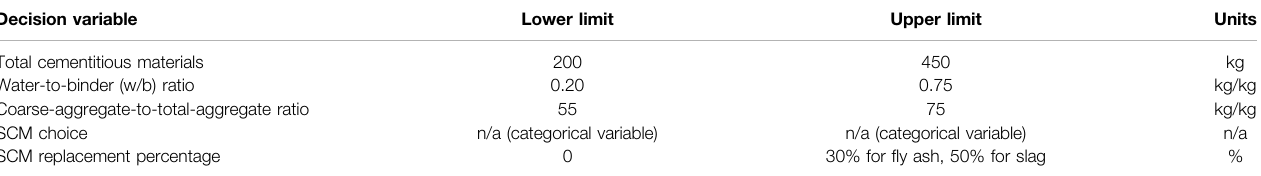
TABLE 1 | Decision variables upper and lower limits.